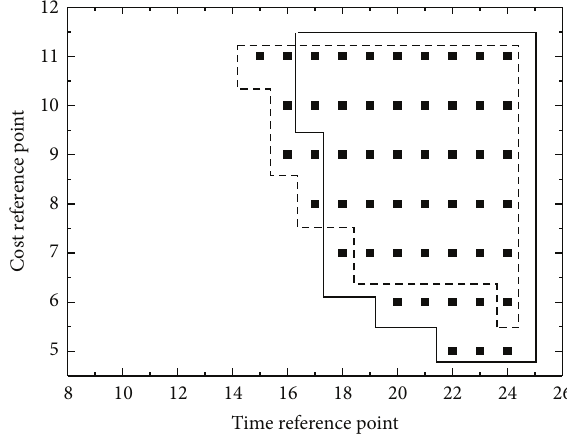
Figure11:Possiblereferencepointsofcarpoolingsuccesswithtraffic congestion rate